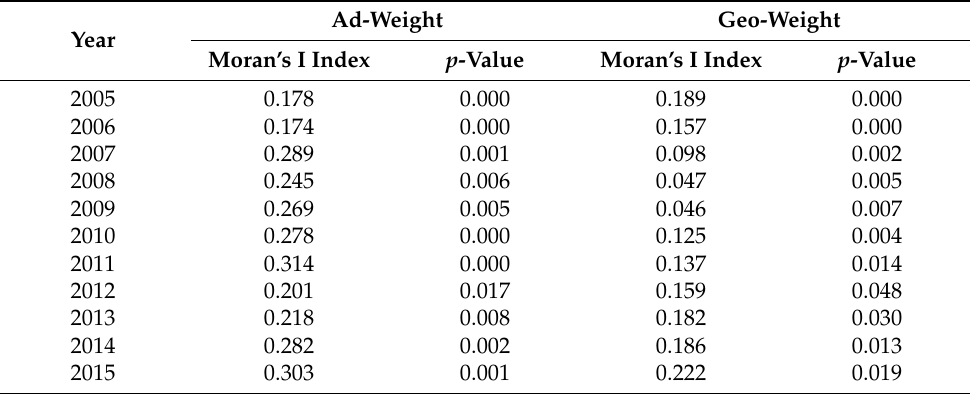
Table 3. Morans’I index of food safety